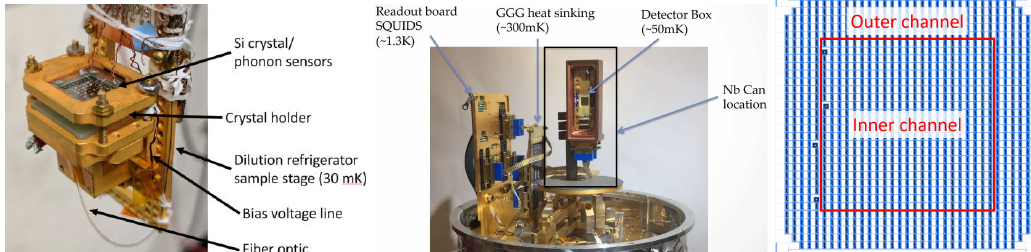
Figure 9: Left: SuperCDMS-HVeV Run1 detector mounted on the mixing chamber stage of a dilution refrigerator with a fiber optic to illuminate the detector from below. Center: SuperCDMS-HVeV Run2 detector installed in an adiabatic demagnetization refrigerator. Right: Drawing of the phonon sensor mask of the HVeV Run2 detec- tor. Two channels with the same area are visible and their contacts highlighted with darker squares. Figures and captions from Refs. [ 49,50 ] 3